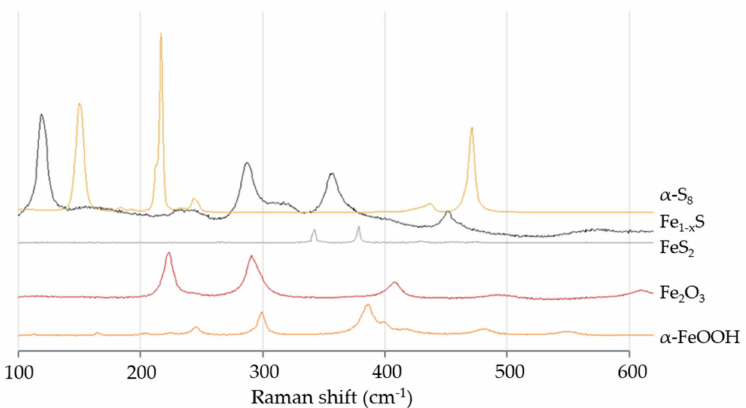
Figure 3. Raman spectra of reference compounds goethite ( α -FeOOH), hematite (Fe 2 O 3 ), sulfur ( α -S 8 ) pyrite (FeS 2 ) and partially oxidized mackinawite (Fe 1 − x